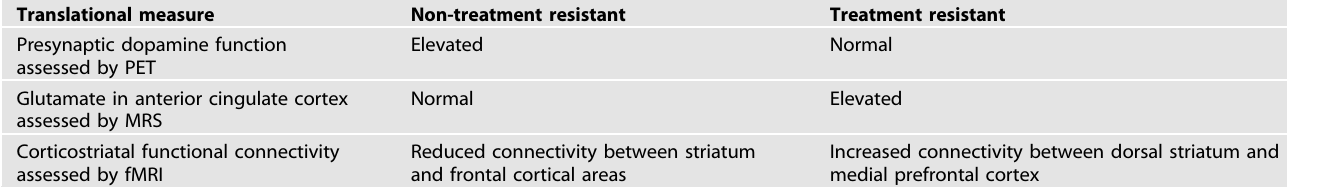
Table 2. Criteria for treatment-resistant and non-treatment-resistant